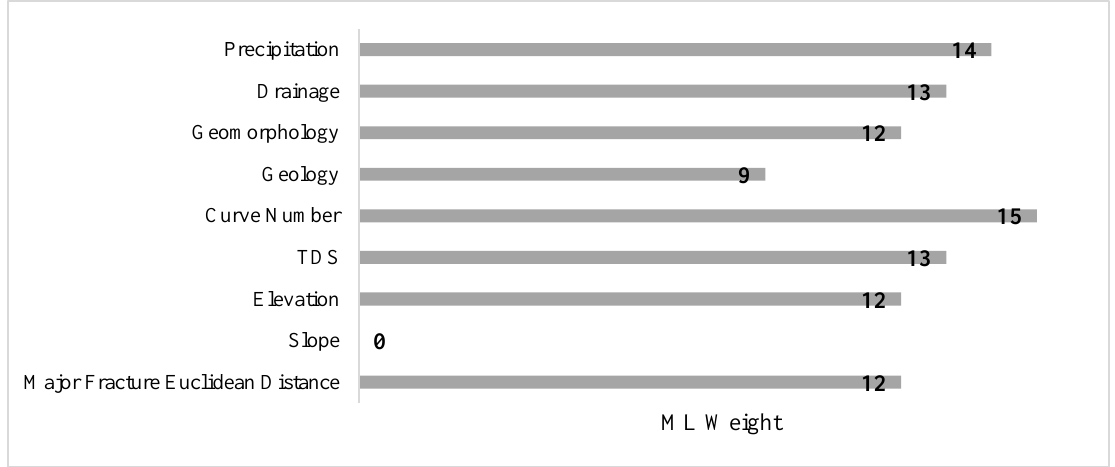
Figure 4. Thematic layer weighting using ML